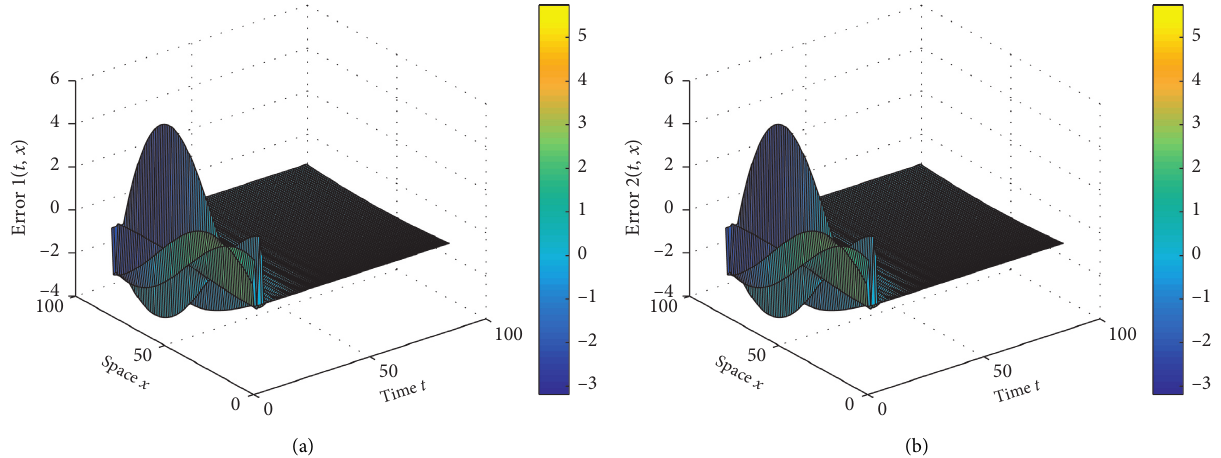
Figure 6: Synchronization errors between systems (46) and (47), with controller